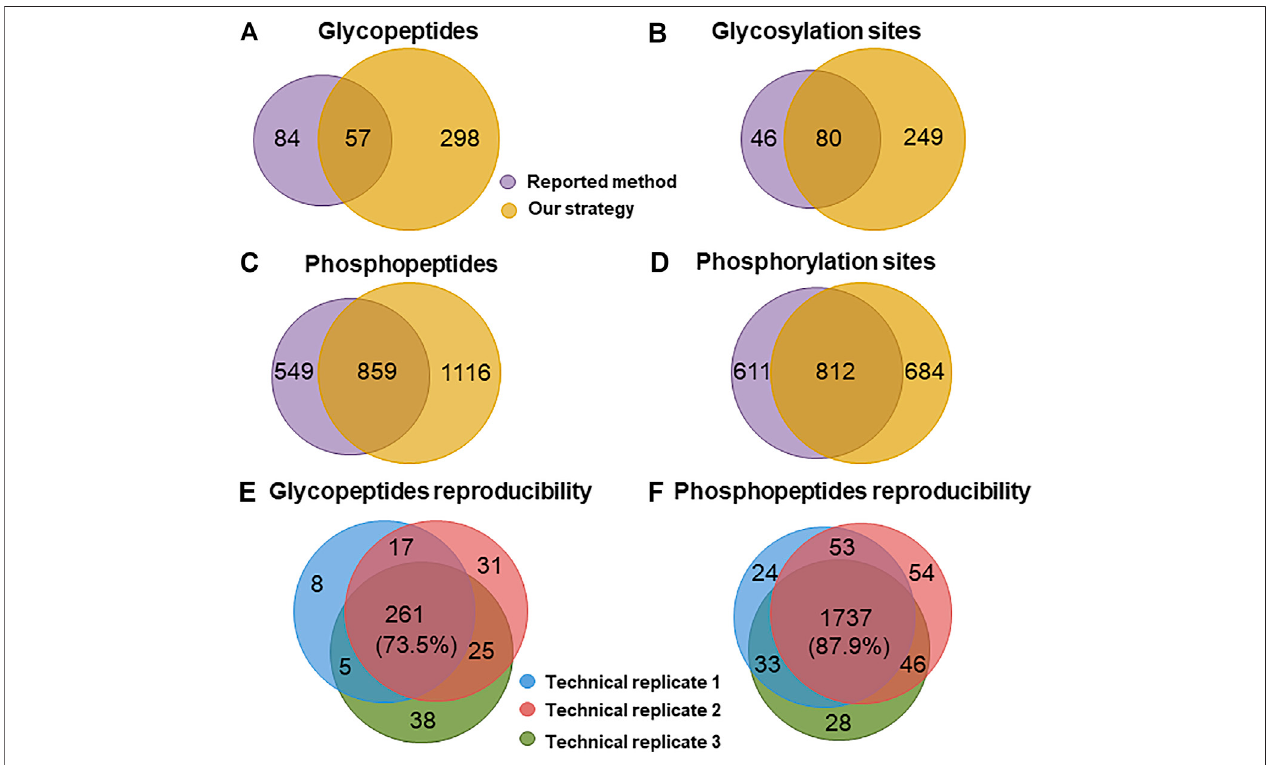
FIGURE 4 | Comparison of the performance for identifying glyco- and phosphopeptides from a mouse brain. Venn diagram analysis of the number of (A) glycopeptides, (B) glycosylation sites, (C) phosphopeptides, and (D) phosphorylation sites identi fi ed with the reported method and our strategy. Reproducibility for (E) glyco- and (F) phosphopeptides among three technical replicates of our